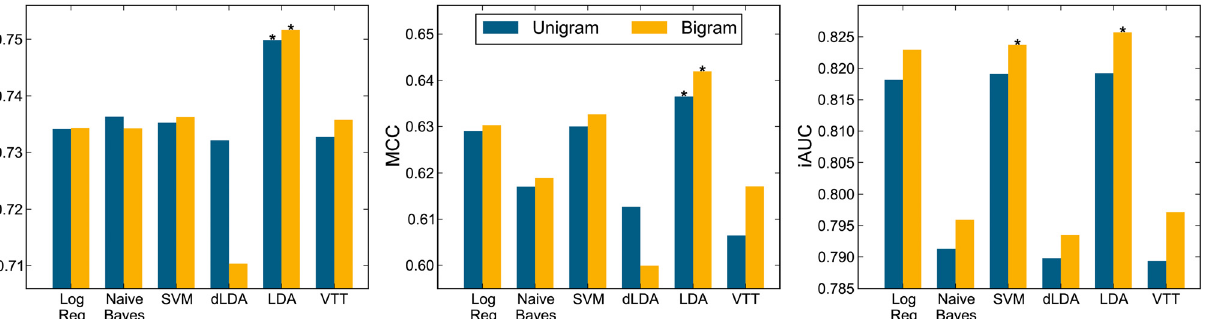
Fig 4. Sentence classification performance. Performance for both unigram and bigram runs on non-transformed features. Left: F1 measure. Middle: MCC measure. Right: iAUC measure. The best classifier configuration, and configurations not significantly different ( p > 0.05, one-tailed test) from it, marked with asterisk ‘ * ’ .